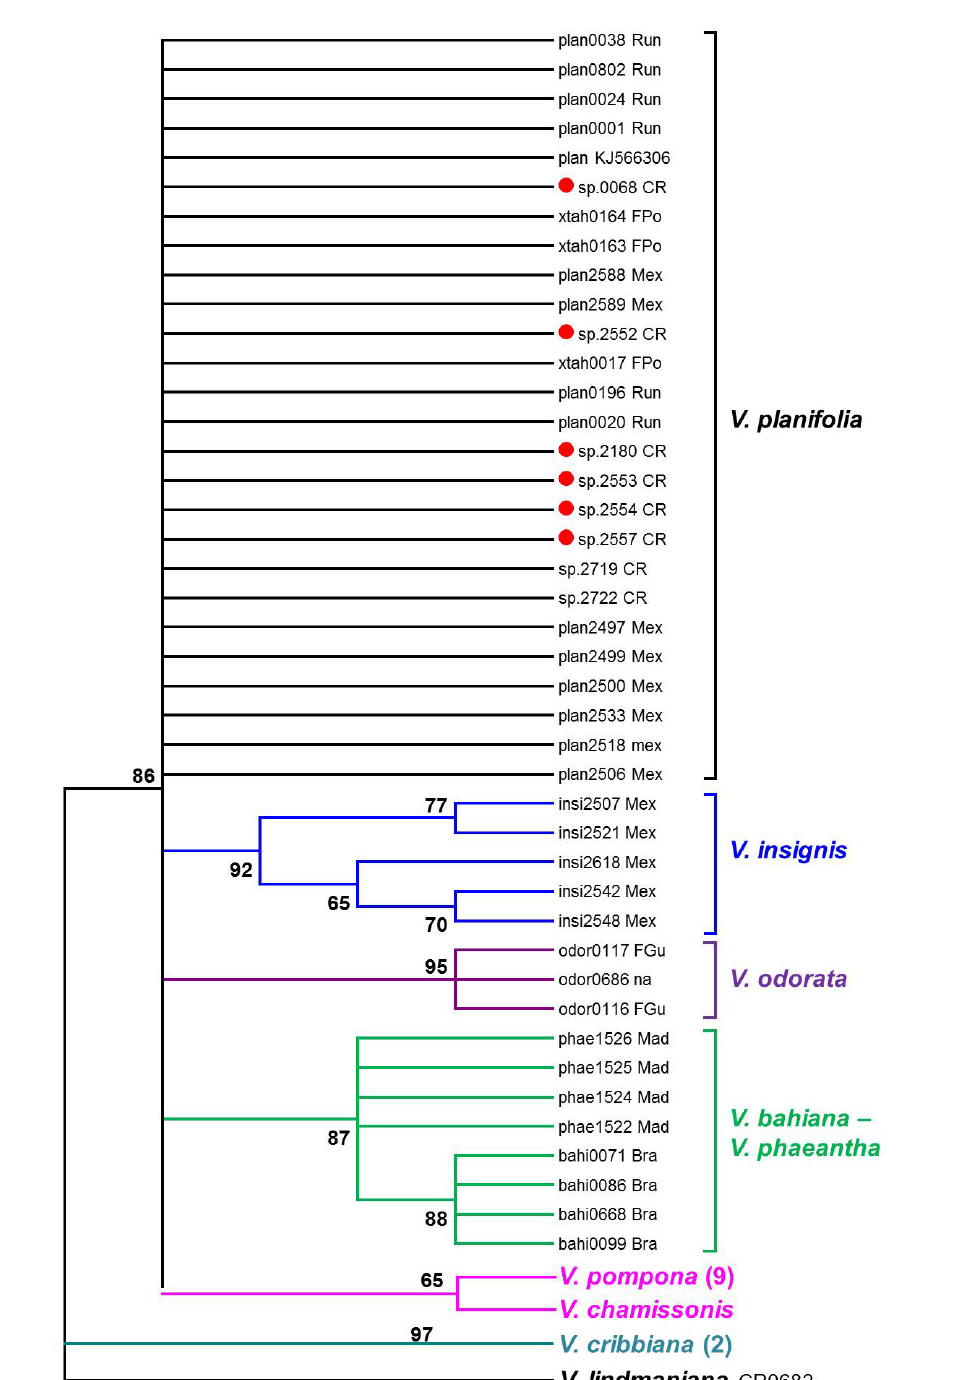
Fig. 5. Phylogenetic tree derived from the partial mat K sequences (725 positions) of the 55 accessions listed in Table 1, showing the Vanilla sotoarenasii M.Pignal, Azofeifa-Bolaños & Grisoni sp. nov. accessions (red dots) within the V. planifolia clade but distinct from other related species. The tree was inferred using the Maximum Likelihood method based on the Hasegawa-Kishino-Yano model and Gamma distribution of evolutionary rates. The figures indicate the percentage of bootstrap support. Countries of origin: Bra = Brazil; CR = Costa Rica; FGu = French Guiana; FPo = French Polynesia; Mad = Madagascar; Mex = Mexico; Run = La Réunion; na = geographic origin not available. Numbers in brackets indicate the number of similar accessions merged in one branch for outgroup